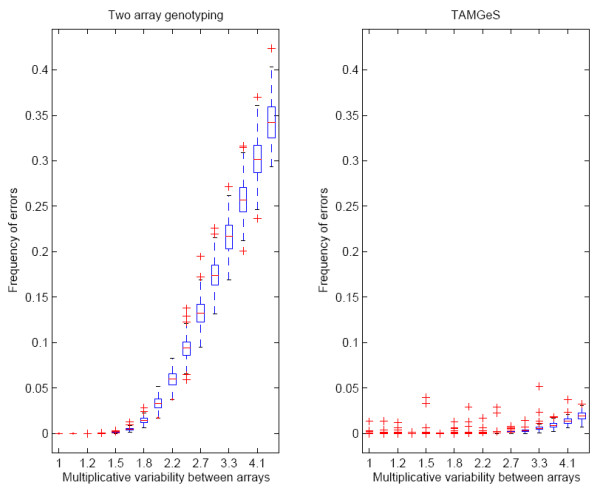
Box plots of genotyping error frequency computed on synthetic data. Both graphs report on the abscissa the multiplicative variability between the two arrays, and on the ordinate the frequency of genotyping errors. The graph on the left shows the results obtained using the direct Two-Array Method; the one on the right, the results obtained using TAMGeS. The greater robustness of TAMGeS is clearly evident.